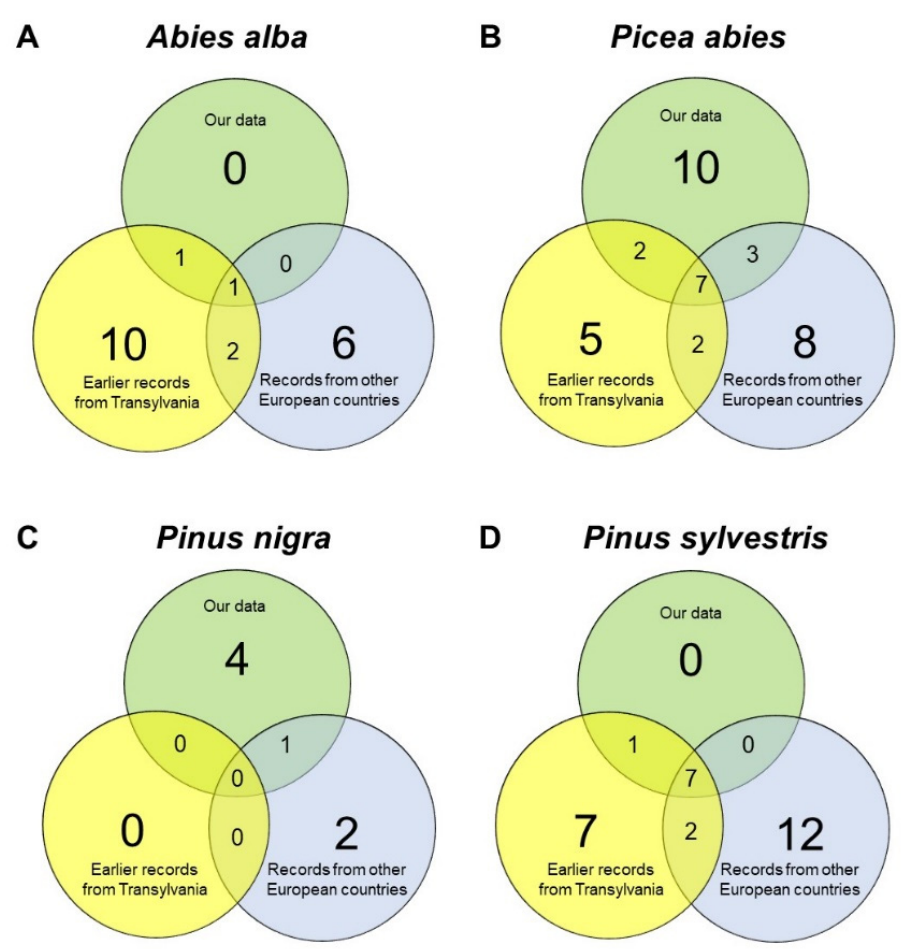
Figure 2. Venn diagram showing the total number and overlapping of medical uses recorded in the study area and other countries related to the Carpathian Basin. ( A ) Abies alba , ( B ) Picea abies , ( C ) Pinus nigra , and ( D ) Pinus sylvestris .